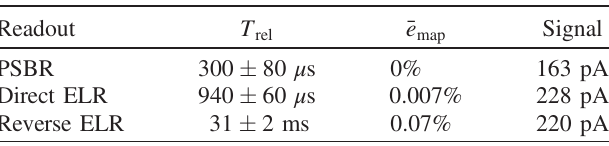
TABLE I. Comparison of readout parameters between the PSBR and the two ELR variations for donor 1. Parameters are measured using methods described in Secs. II C, II D, and II F, and Ref. [38]. The effect of the different relaxation mechanism of the reverse ELR can clearly be seen as it makes the relaxation time over 100 times longer than the PSBR and over 30 times longer than the direct ELR. However, it is important to